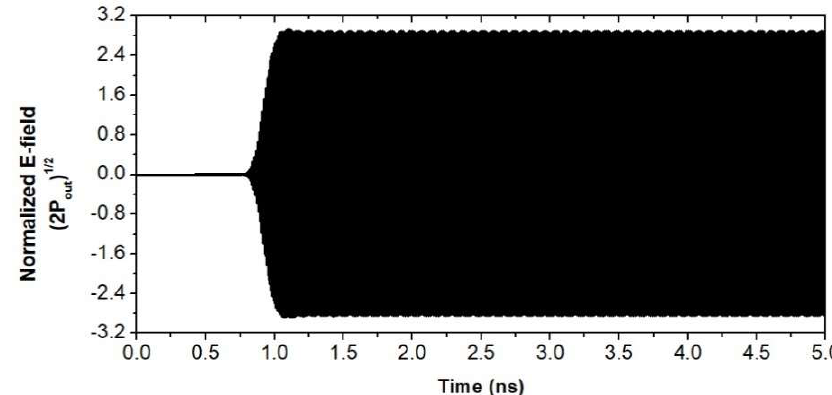
Figure 19. Output signal of pre-amplification section.